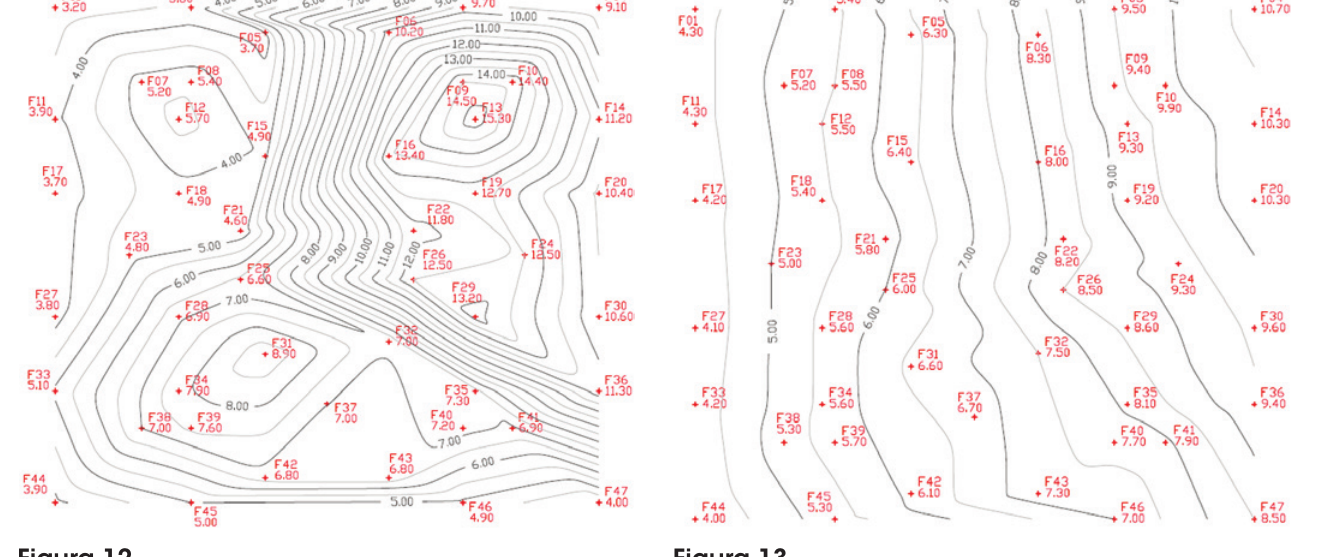
Curva de isorecalque do modelo CASCA RIG